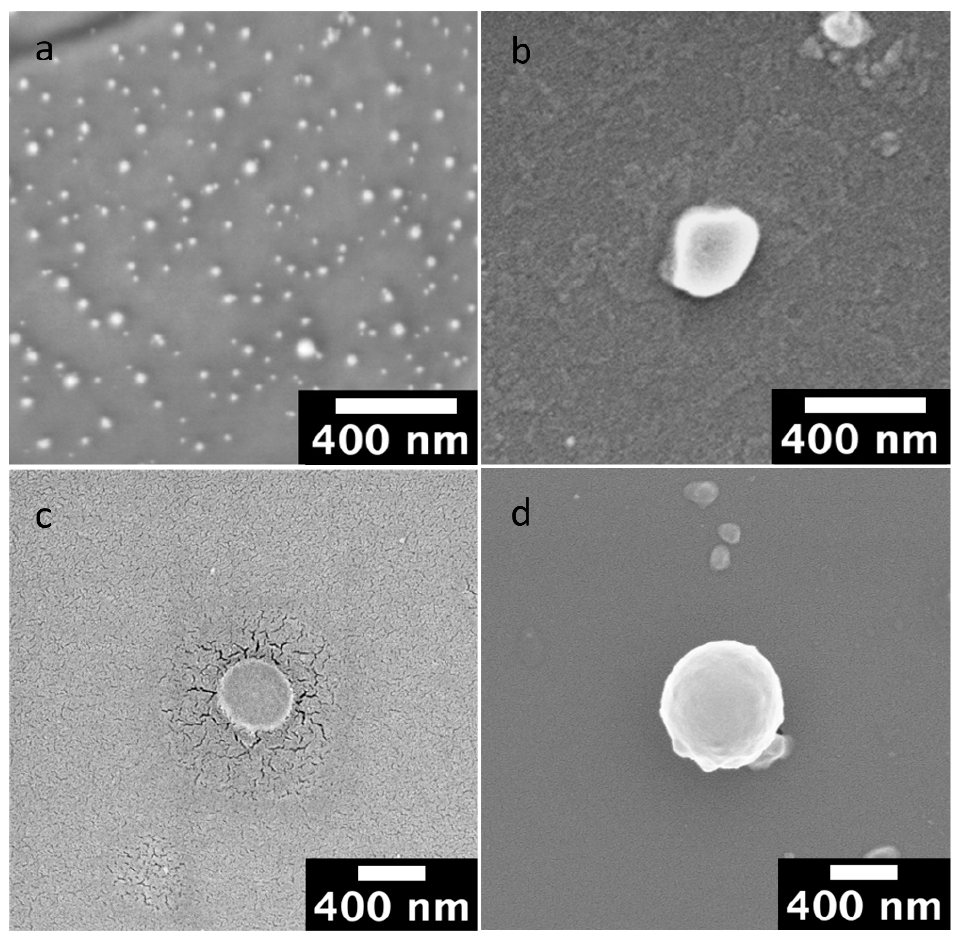
Figure 1. Scanning electron microscopy (SEM) micrographies of ( a ) NANO-B (Scale bar= 400 nm); ( b ) NANO-B complex (Scale bar= 400 nm); ( c ) NANO-A (Scale bar= 400 nm); ( d ) NANO-A complex (Scale bar= 400 nm).